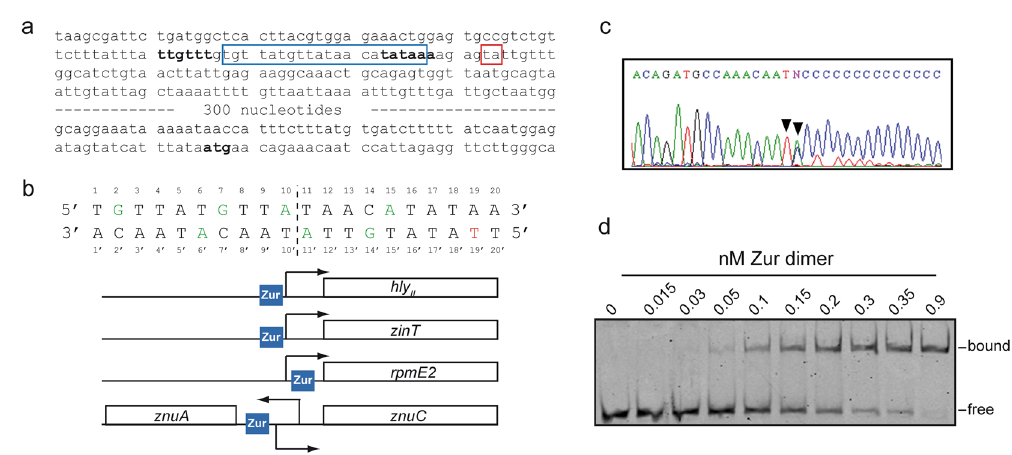
Figure 6. Zur protein binds to the hly II promoter. ( a ) Sequence of the hly II operon upstream of hlyC . In bold are indicated the first codon (ATG) of hlyC and the putative − 10 and − 35 boxes of the promoter. Within the blue box is indicated the putative binding site of Zur. The red box indicates the transcriptional start found by 5 ′ RACE assays. ( b ) Sequence of the putative Zur binding site found in the hly II operon promoter. Bases recognized by Zur dimers are colored: green for conserved bases and red for the only base that is not conserved. A dashed line represents the symmetry axis. Below are depicted the positions of Zur binding sites in promoters of znuABC , zinT , rpmE2 9 and hly II . Zur boxes were drawn to scale in respect of transcription start site. ( c ) Sequence of the 5 ′ RACE assay using J96 total RNA samples grown in LB at 37 °C up to late log phase. The two bases identified as a transcriptional start are indicated with arrowheads. The N residue corresponds to a mix of A and C bases. ( d ) Electrophoretic mobility shift assay. Titration of a Cy5 labeled 50-bp hly II promoter fragment carrying the putative Zur binding site was carried out in the presence of excess salmon sperm DNA which serves as a non-specific competitor. Samples contains 60 pM DNA, plus 0, 15, 30, 50, 100, 150, 200, 300, 350, 900 pM Zur (calculated as dimer), respectively. Samples were resolved on a 10% polyacrylamide gel. Both gel and electrophoresis buffers contain 50 µ M ZnSO 4 . Full-length gel image is shown in Fig.